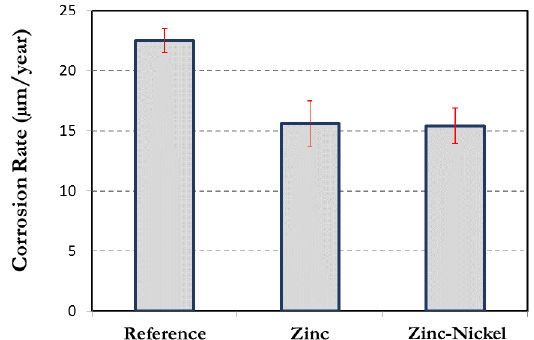
Figure 9. Corrosion rates of reference and coated rebars exposed to salt spray